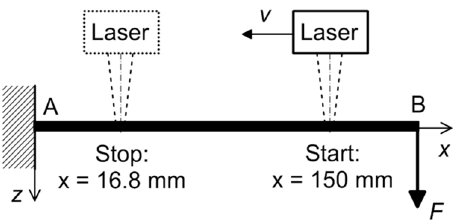
Figure 3. A scheme of the thermo-mechanical bending process applied in the analysis of the moment—curvature relations.